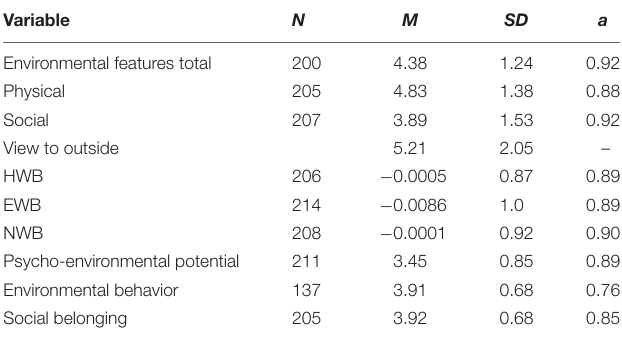
TABLE 2 | Basic descriptive statistics for all variables including Cronbach